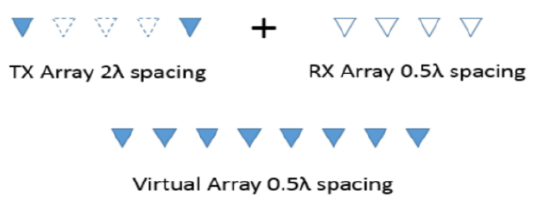
Fig. 4. Organization of Data